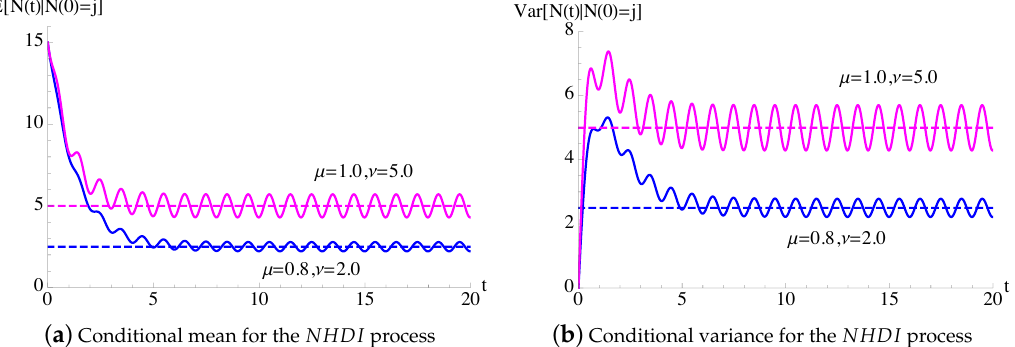
Figure 6. For the NHDI process of Figure 5, the conditional mean and the conditional variance (37) are plotted as function of t for j = 15, a = 0.9, Q = 1.0 and for some choices of µ and ν . The dashed lines indicate the asymptotic mean and the asymptotic variance of the HBDI process, given in